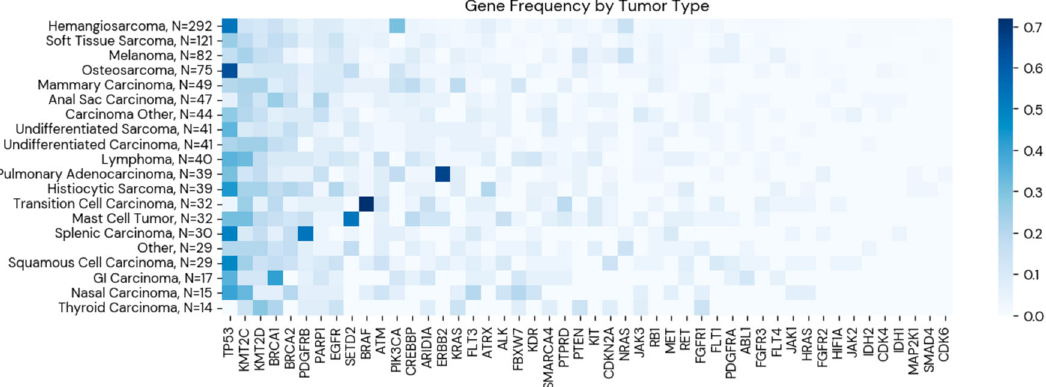
Fig. 2 Frequency of Gene Mutations by Tumor Type. For each tumor type (row), the relative frequency of tumors that contain a given mutation is contained in each column value. For example, a value of 1 would mean that all instances of a given tumor type contain a certain mutation. The sample size for each tumor re fl ects the number of cases with reported genetic data.